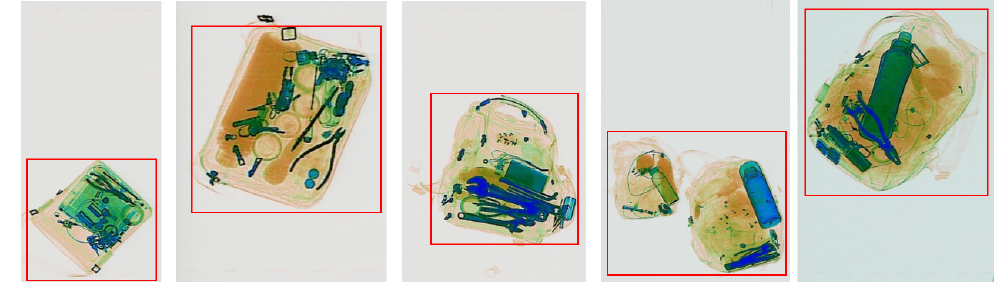
Figure 8. Results from TDC using RFB Net backbone. The red bounding boxes mark the output after cropping when using k =